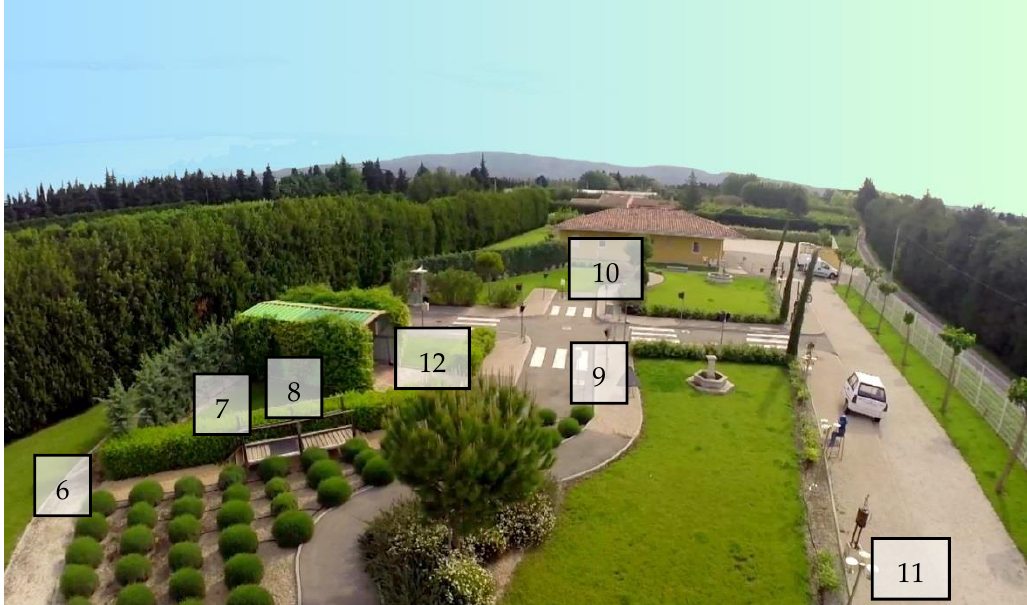
Figure 2. Senses itinerary of the Frederic Gaillanne Foundation (FGF). The locations of the items completed on this course (outdoor part) are indicated by their numbers, from 6 to 12. Table 1. Scores obtained from the emotional reactivity test (ERT) test associated with the corresponding items. UP Score Items Table 2. Emotional reactivity test score grid for each item. Evaluation